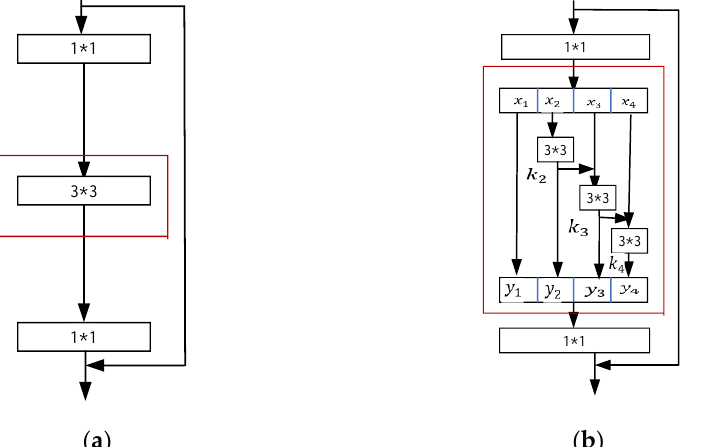
Figure 4. ResNet and Res2net network infrastructure diagram. ( a ) ResNet infrastructure diagram; ( b ) Res2Net infrastructure diagram.